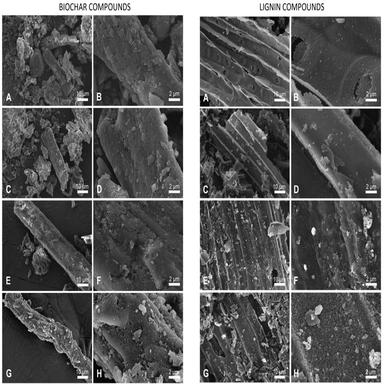
SEM images of biochar and lignin compounds: a) B/L x1500 times, b) B/L x7000 times c) B/L+ RT21' x1500 times, d) B/L+ RT21' x7000 times e) B/L + RT27' x1500 times, f) B/L + RT27' x7000 times, g) B/L + RT31' x1500 times, and h) B/L + RT31' x7000 times.